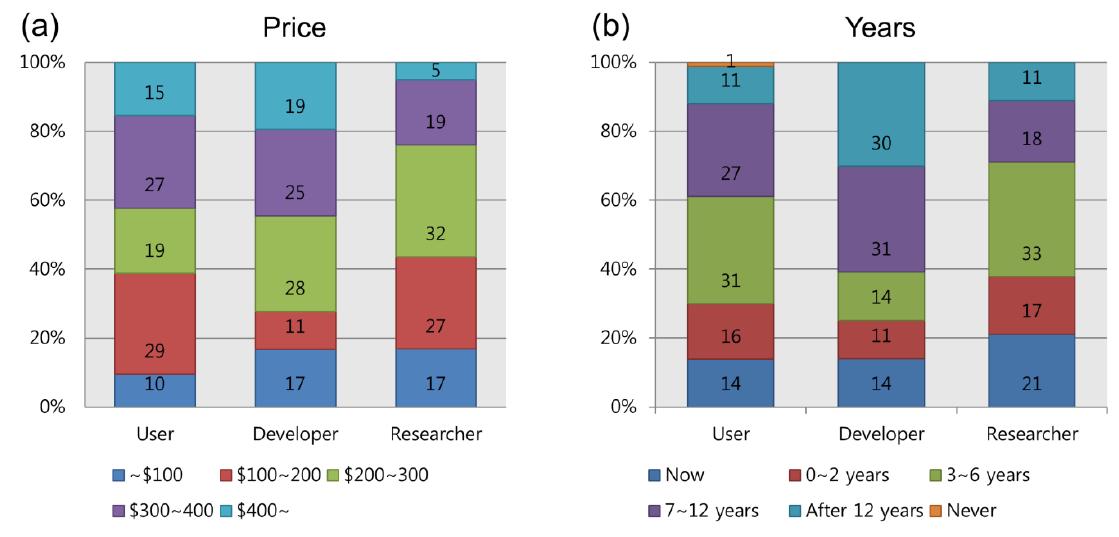
Figure 10. Acceptable cost for BCI games and devices ( a ) and expected number of years until BCI games become generally available ( b